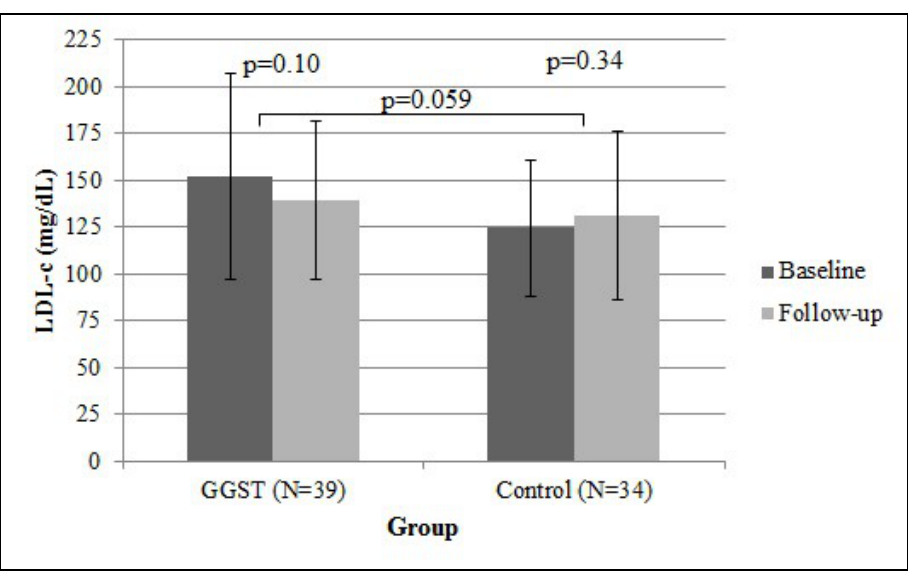
Figure 4. Association of GGST with change in LDL-c. Displayed are means and standard error bars of LDL-c. Individuals receiving GGST had a greater decrease in LDL-c (−12.4 ± 45.4 mg/dL) compared to control subjects (6.3 ± 37.8) over one-year follow-up. GGST = genotype guided statin therapy; LDL-c = low-density lipoprotein